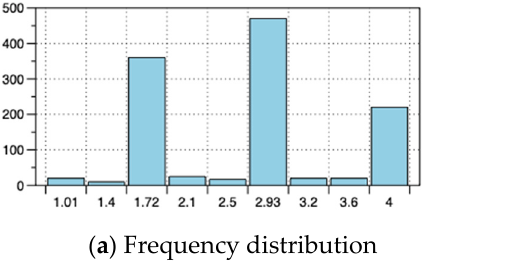
Table 5. Final database structure of Map for Storm and Flood Insurance Management.